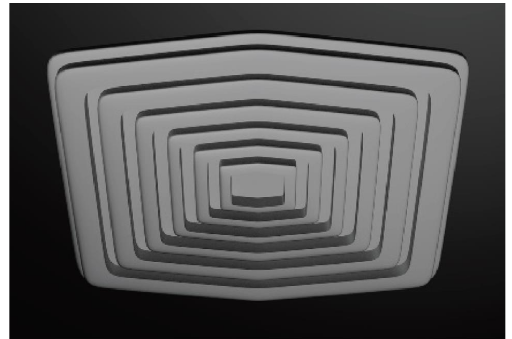
Figure 7: Concentric grooves